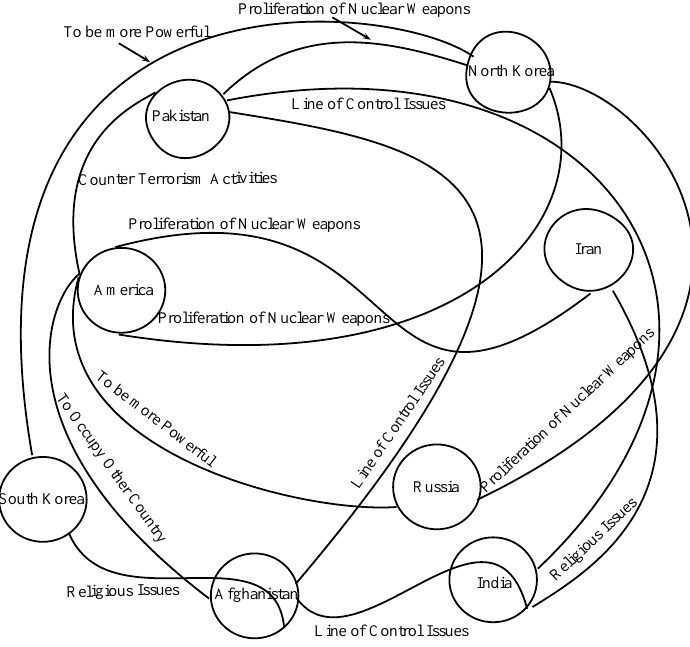
Figure 15. Fuzzy-graph structure depicting most controversial issues among different Figure 15: Fuzzy graph structure depicting most controversial issues among different countries